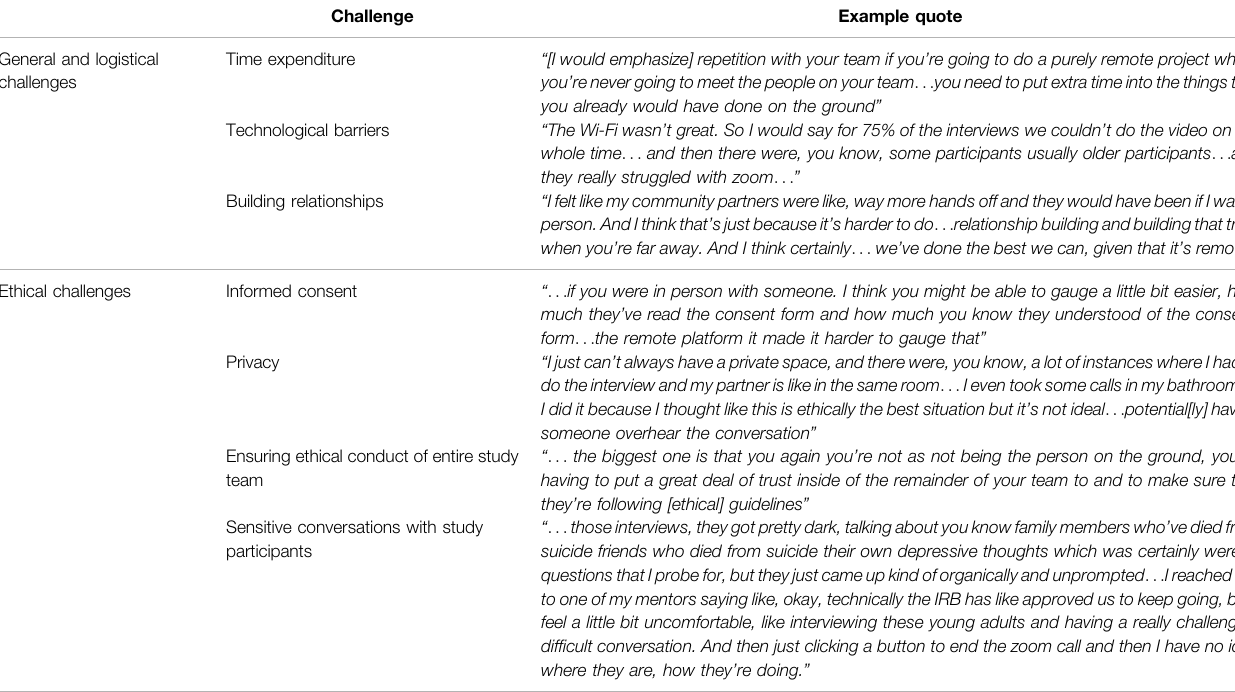
TABLE 1 | Examples of challenges students faced in global health research during COVID-19.